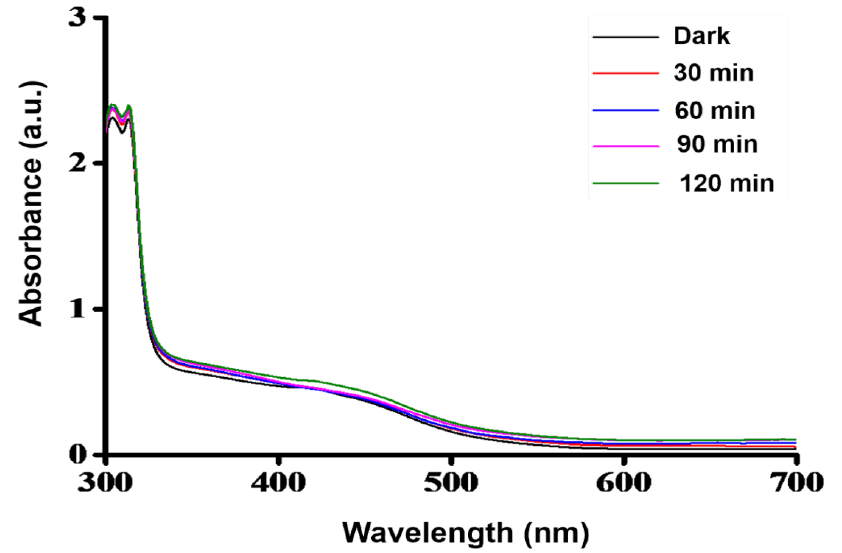
Figure 7. NGQDs@EC photocatalyst was used to record UV-visible spectroscopy for photocatalytic NADH regeneration at various time intervals.